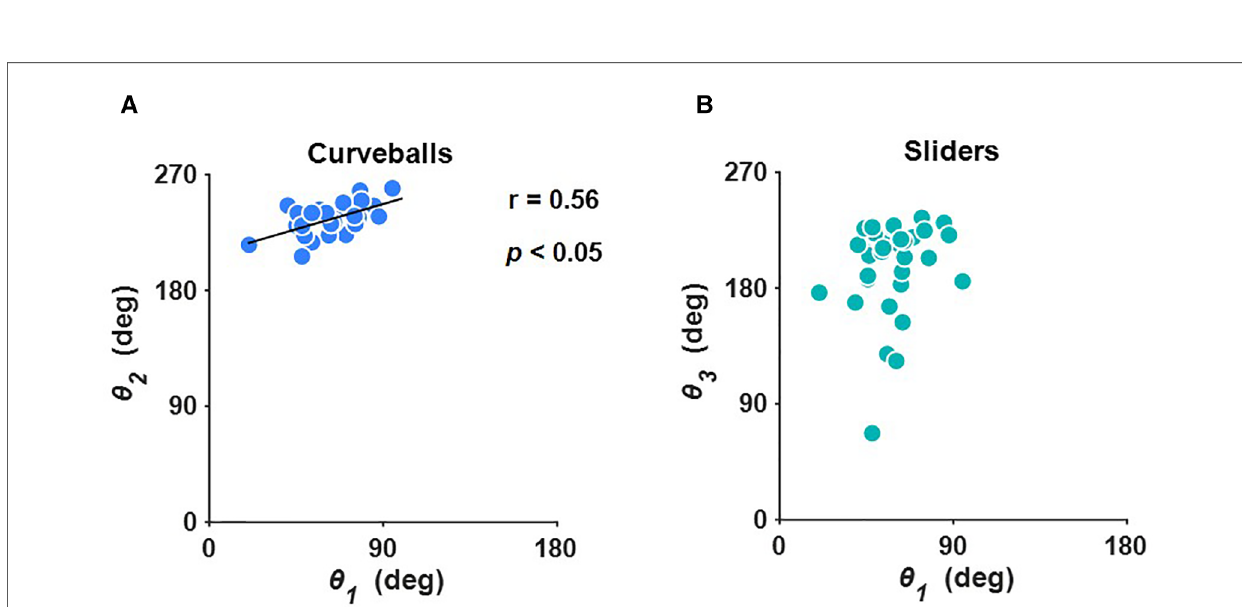
FIGURE 4 Relationship between ( A ) the angle of four-seam fastballs ( θ 1 ) and curveballs ( θ 2 ), and ( B ) the angle of four-seam fastballs ( θ 1 ) and sliders ( θ 3 ). r and p stand for the correlation coef fi cient and probability value,